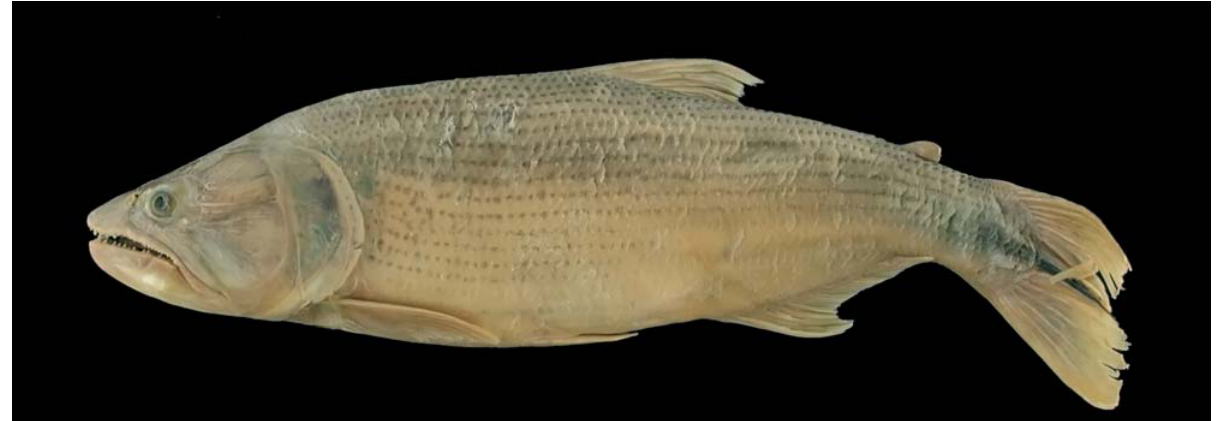
Fig. 2. Salminus franciscanus , paratype, MZUSP 38999, 451.0 mm SL; Brazil, Minas Gerais, rio São